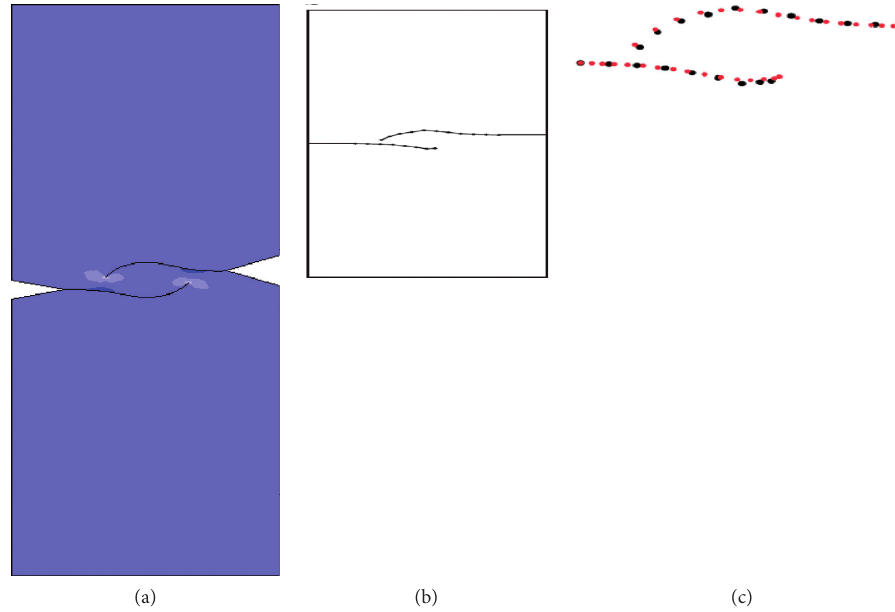
Figure 13: Final crack growth path. (a) Present study. (b) Price and Trevelyan [32]. (c) [30].